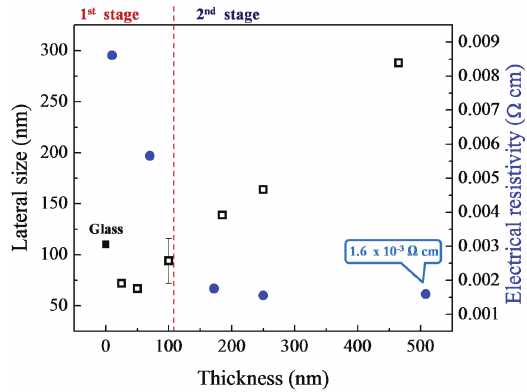
Figure 7. Lateral size calculated from a Lorentz fitting of the 2D power spectrum of 2 mm × 2 mm AFM images and electrical resistivity as a function of